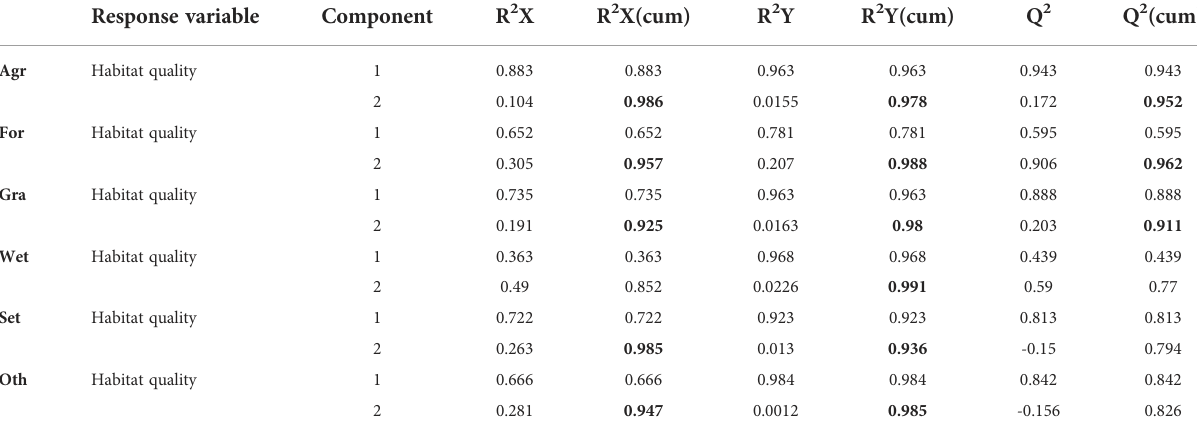
TABLE 3 Summary of the PLSR model output with respect to habitat